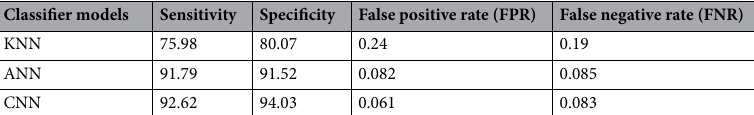
Table 3. Obtained results and compared different classifier models in various